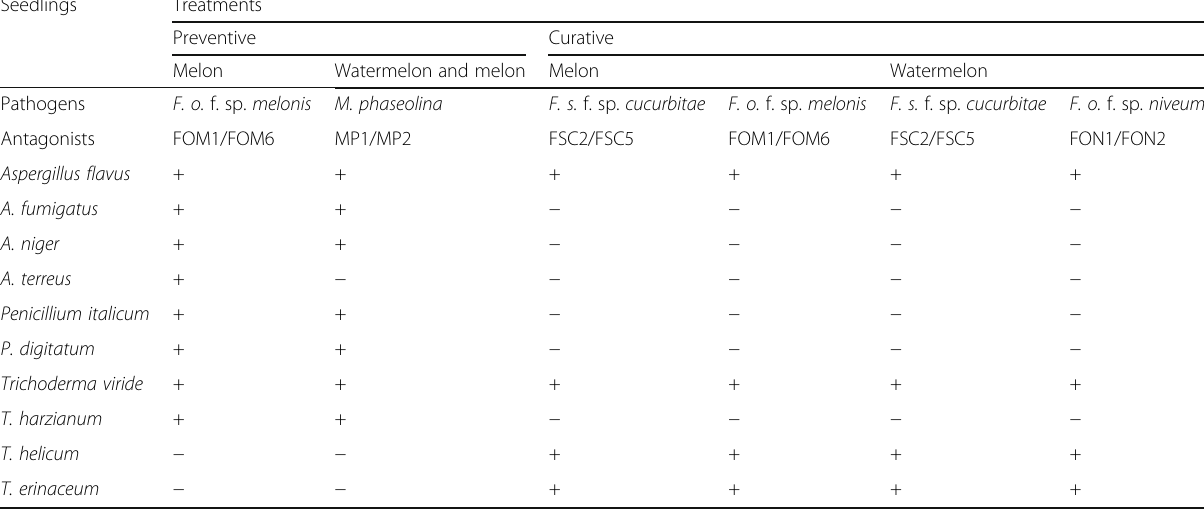
Table 2 Different treatments applied on watermelon and melon seedlings in vivo biological control assay. Two type of treatments: preventive (application of fungal antagonist before 24 h of pathogen) and curative (application of fungal antagonist 24 h after